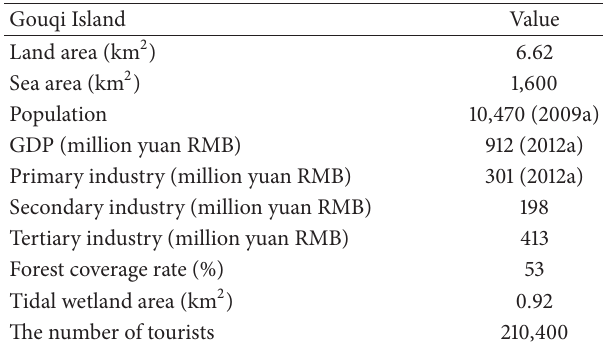
Table 1: The basic information of Gouqi